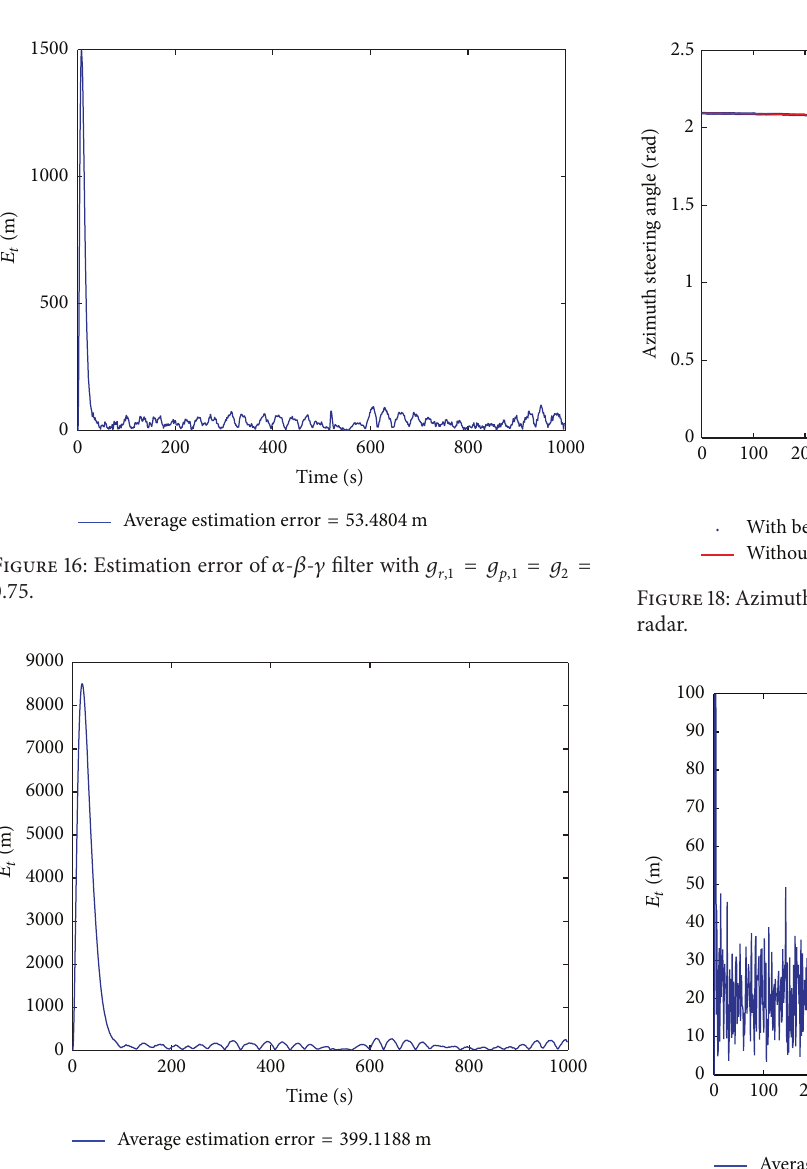
Figure 19: Estimation error of GA based adaptive 𝛼 - 𝛽 - 𝛾